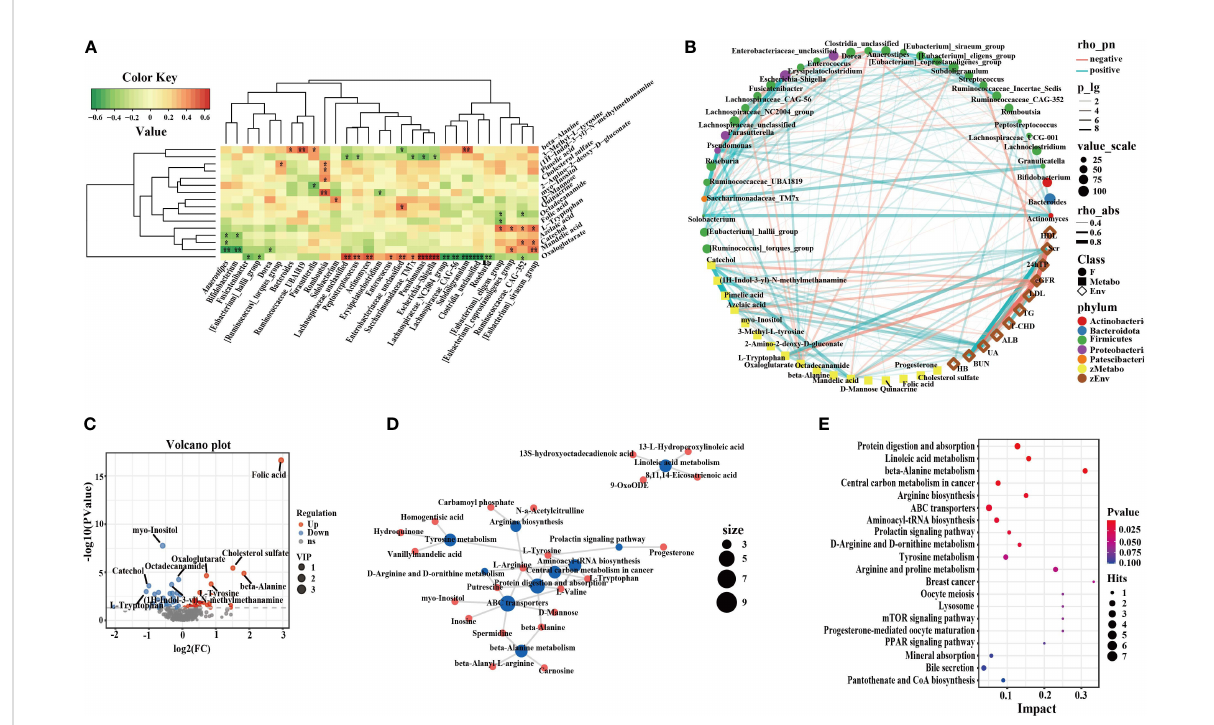
FIGURE 5 Correlation of intestinal micro fl ora, metabolites and clinical phenotypes and differential metabolic pathways. (A) The correlation analysis of differential fl ora and metabolites in IgAN (* P < 0.05; ** P < 0.01; *** P < 0.001). (B) Network graph of intestinal micro fl ora, differential metabolites and clinical indices. (C) Volcano plots of differential metabolites in HC. The red dots represented up-regulated differentially expressed metabolites, the blue dots represented down-regulated differentially expressed metabolites, and the gray dots represented metabolites that were detected but did not meet the fi ltering parameter screening. (D) Network graph of differential metabolic pathway in fl uencing factors between IgAN patients and HCs. The blue points represented pathways, and the red points represented metabolites, and the size of the points represented the number of points connected to them. (E) Bubble graph of differential metabolic pathway in fl uencing factors. Each point represented a metabolic pathway. The abscissa was the impact value enriched in different metabolic pathways, and the ordinate was the enriched pathways. And the dots represented the number of corresponding metabolic molecules on the pathway. OPLS-DA, Orthogonal Partial Least Squares-Discriminant Analysis; PPAR, peroxisome proliferation-activated receptor; mTOR, mammalian target of rapamycin; HB, hemoglobin; BUN, blood urea nitrogen; Scr, Serum creatinine; UA, uric acid; ALB, serum albumin; T-CHO, total cholesterol; TG, triglycerides; HDL, high density lipoprotein; LDL, low density lipoprotein; eGFR, estimated glomerular fi ltration rate; 24hTP, 24-hour urinary total protein levels; HC, healthy controls; IgAN, immunoglobulin A